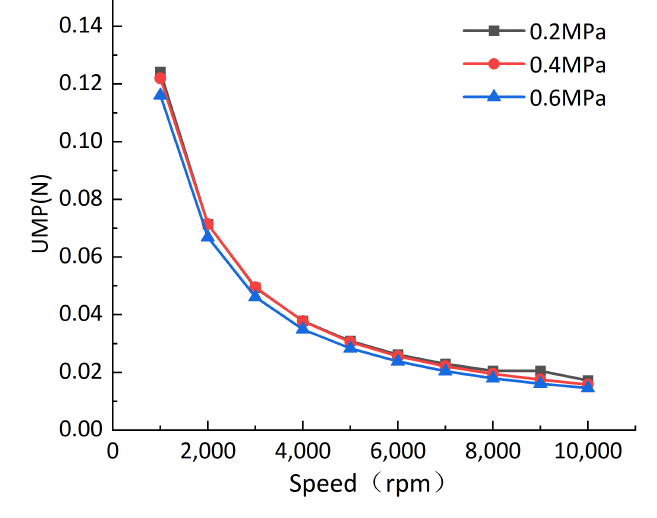
Figure 10. Amplitude of the UMP.